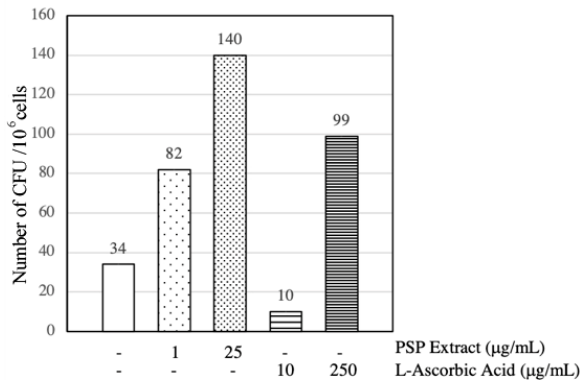
Figure 3. E ff ect of the PSP extract and l -ascorbic acid in inducing colony formation units (CFUs) formation. EPCs were cultured in CFU-Hill Liquid Medium Kit as described in Materials and Methods. The culture was treated with / without 1 µ g / mL PSP extract, 25 µ g / mL PSP extract, 10 µ g / mL l -ascorbic acid or 250 µ g / mL l -ascorbic acid for 48 h. The colony with ≥ 15 EPCs were counted as a CFU.